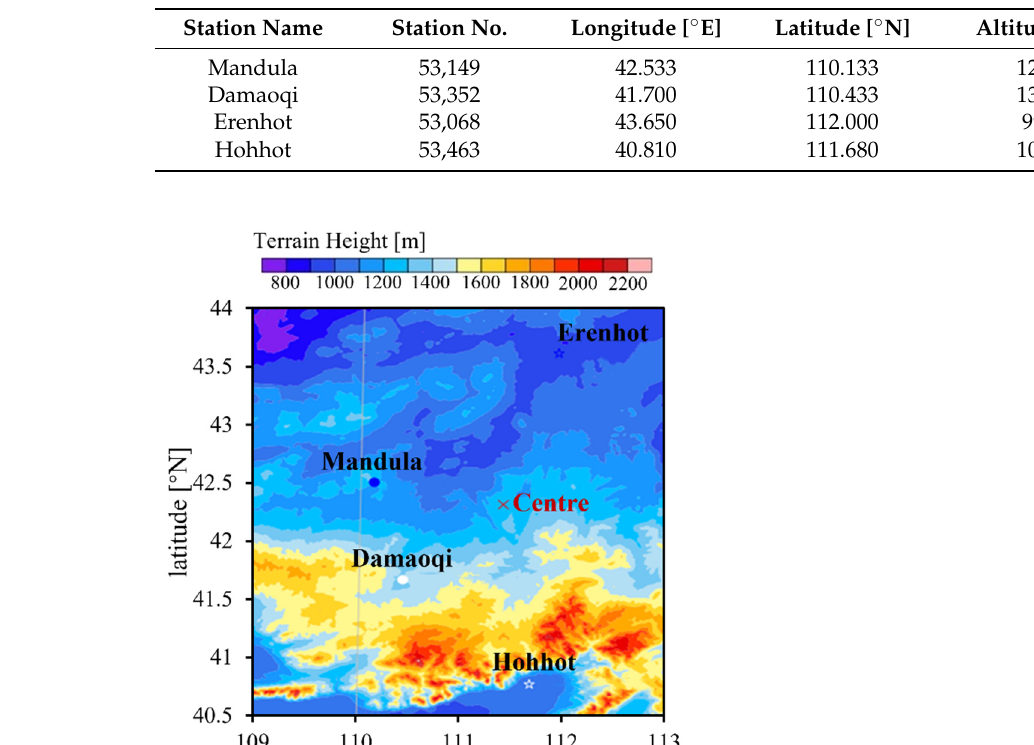
Table 2. The respective position coordinates of the four observation stations.